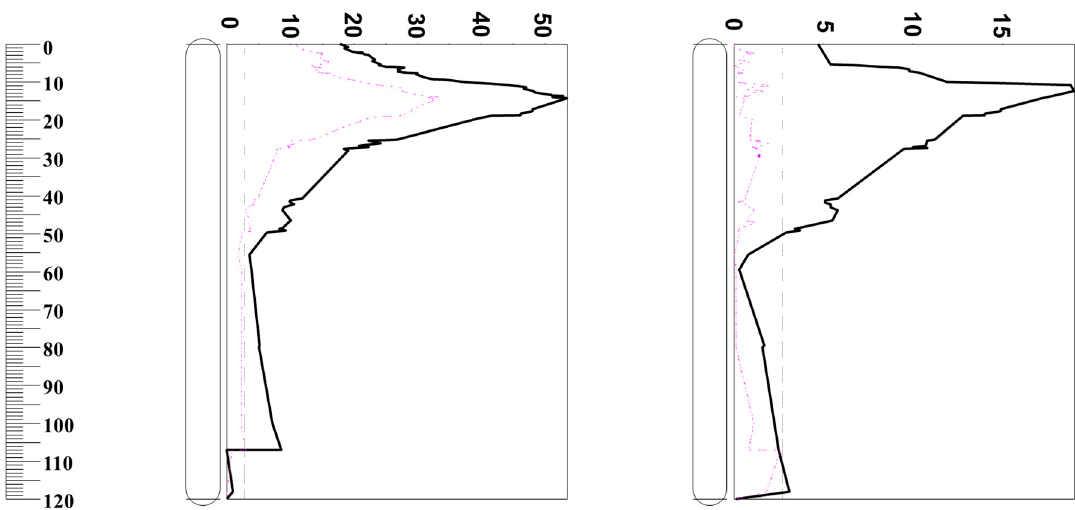
Abbreviations for traits are given in Table 1.